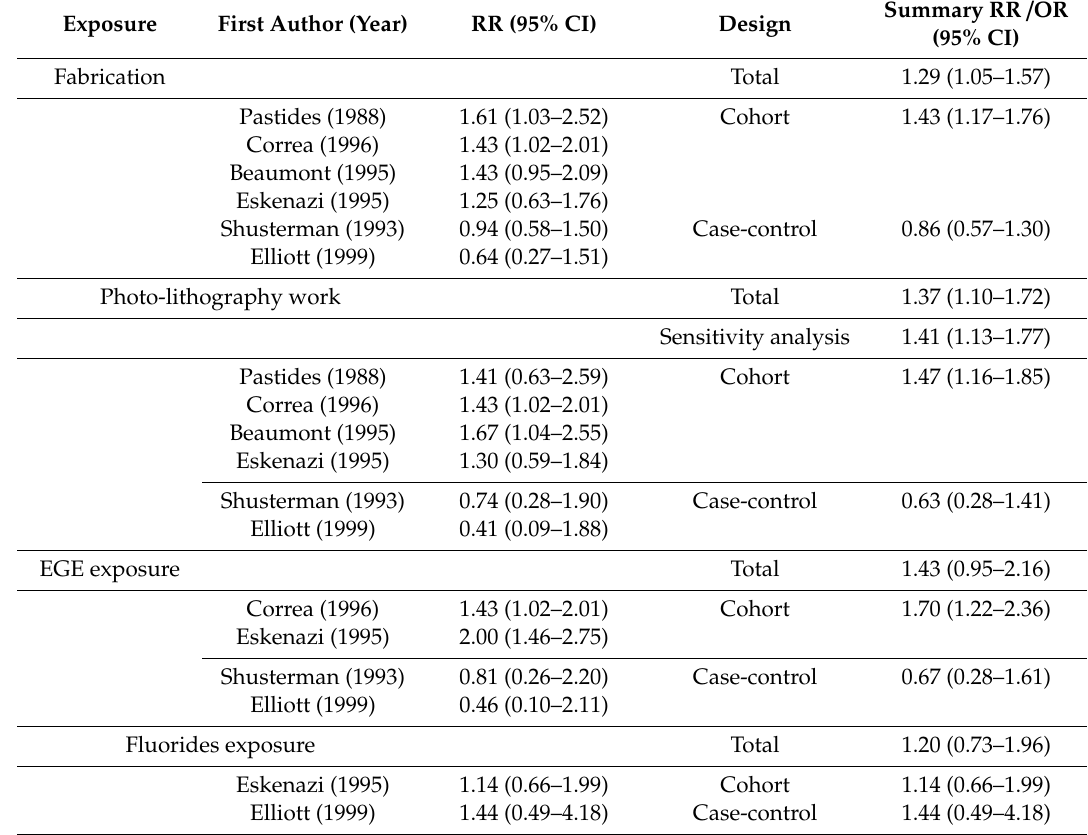
Table 1. Meta-analysis for studies the association between the risk of spontaneous abortion and Fab work, photolithography work, ethylene glycol ether, and fluorides exposure by study design.